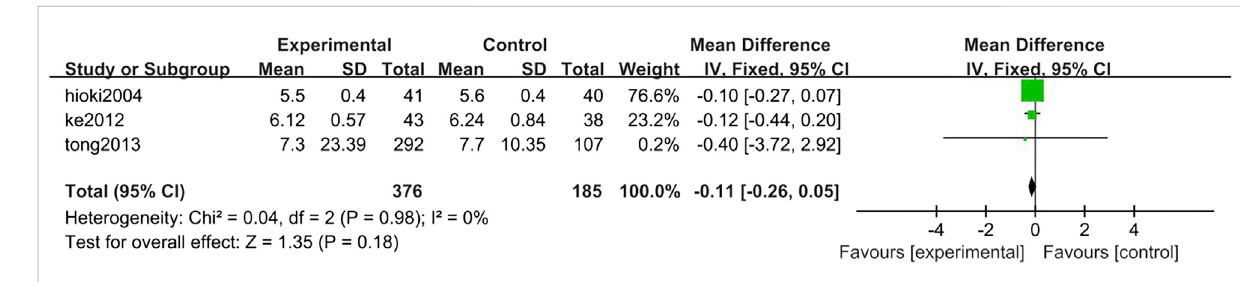
FIGURE 13 Forest plot of HbAlc. Comparison: TCM treatment vs. placeo or blank